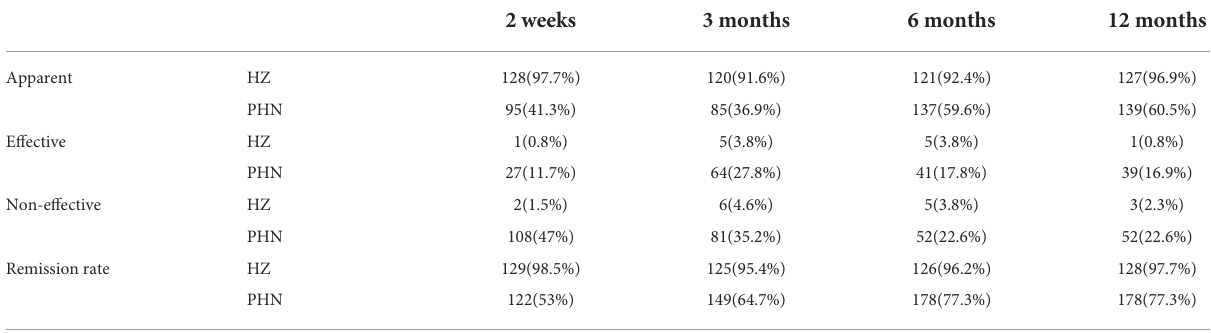
TABLE 3 Pain relief in patients with HZ and PHN.